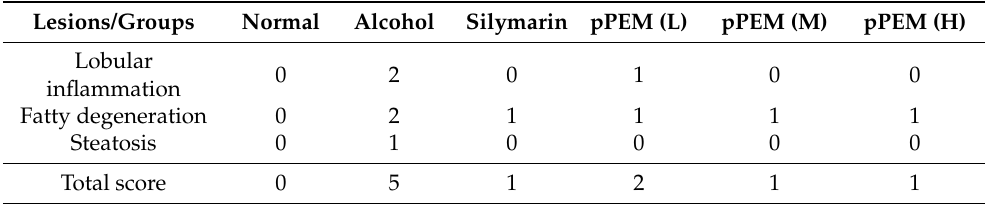
Table 3. Unweighted sum of scores for steatosis, lobular inflammation, and ballooning of hepatocytes in the different